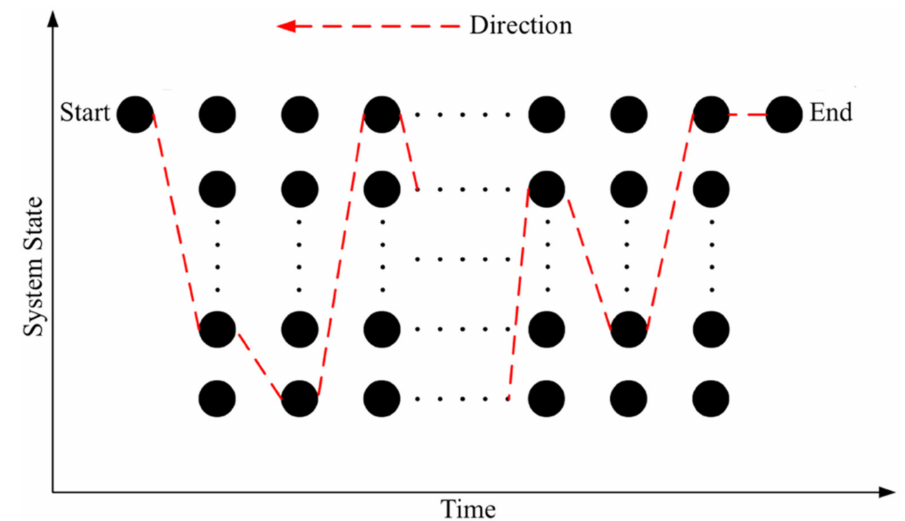
Figure 16. Process of the DP